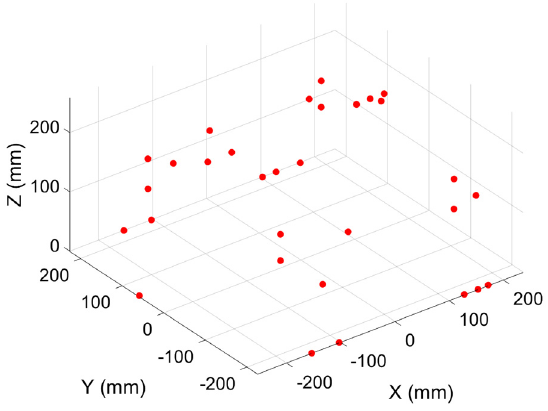
Figure 8. 31 linear axis positions at four artefact balls in the machine frame.